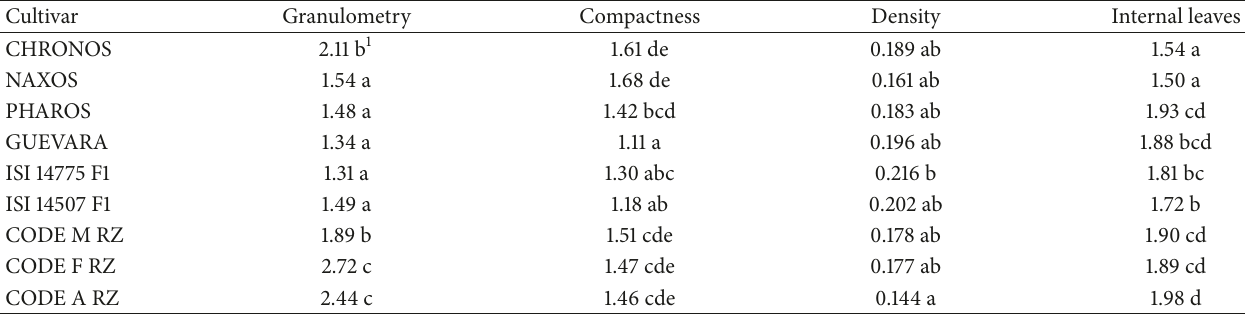
1 In column, values followed by different letters are significantly different at 0.05. Table 4: Quality parameters of heads from nine broccoli